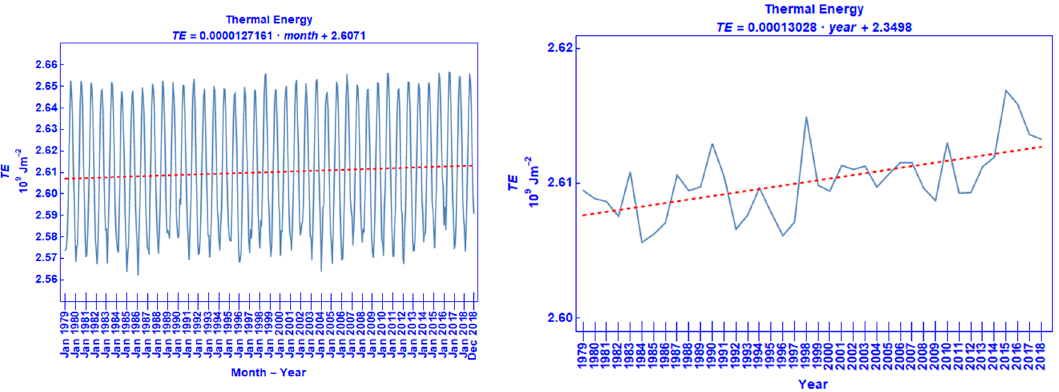
Figure 5. The same as Figure 2, but for TE .